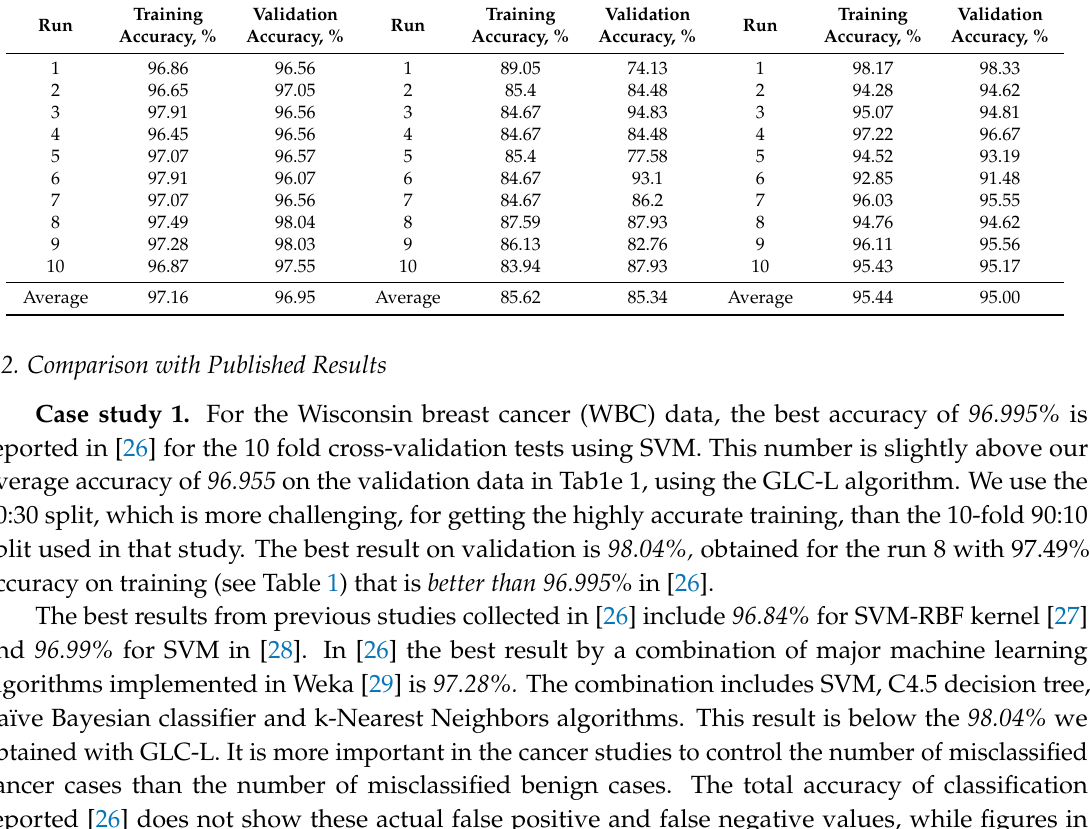
Table 1. Best accuracies of classification on training and validation data with 70–30% data splits. Case Study 1 Results. Wisconsin Breast Cancer